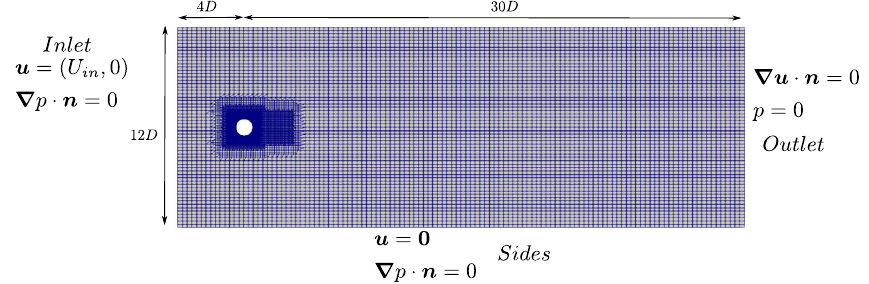
Fig. 5 The computational grid of the problem of the flow around a circular